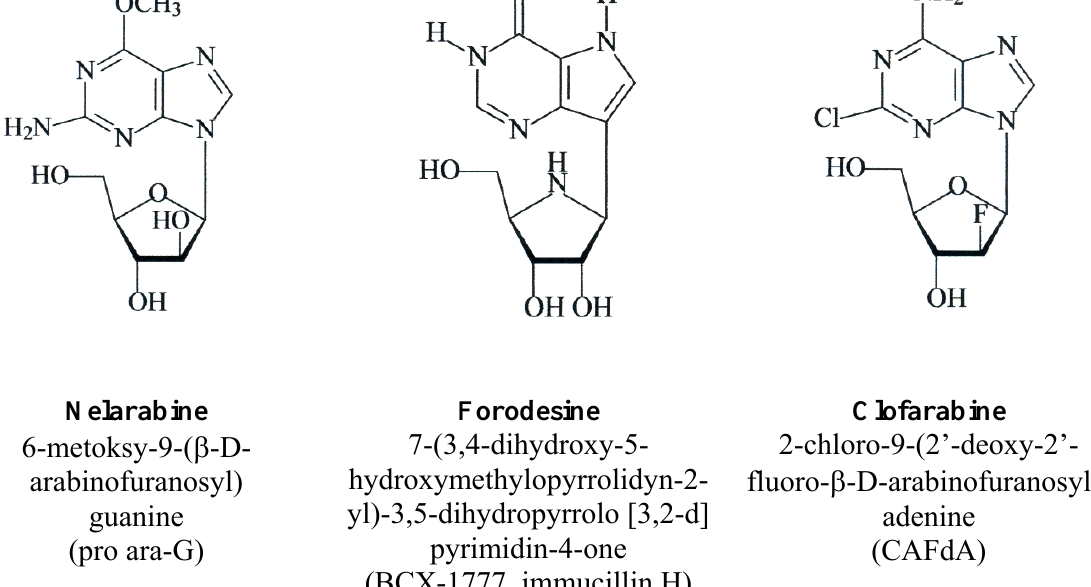
Figure 2. Structures of new nucleoside analogues: nelarabine, forodesine and clofarabine.